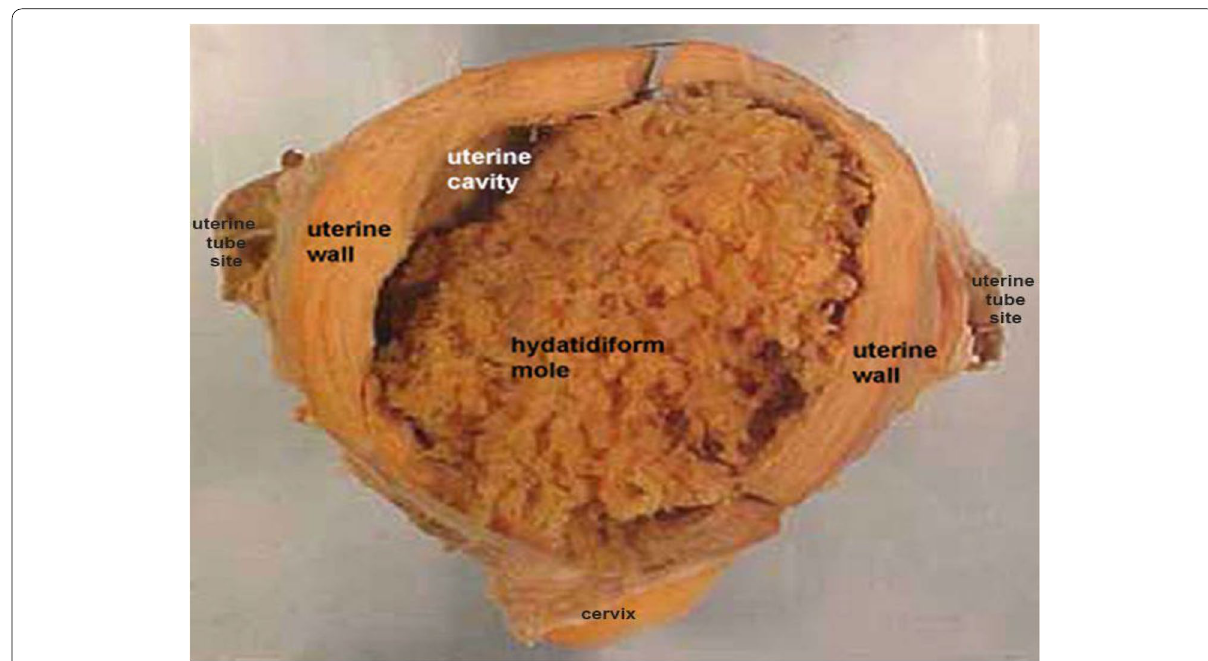
Fig. 1 Image showing hydatidiform mole